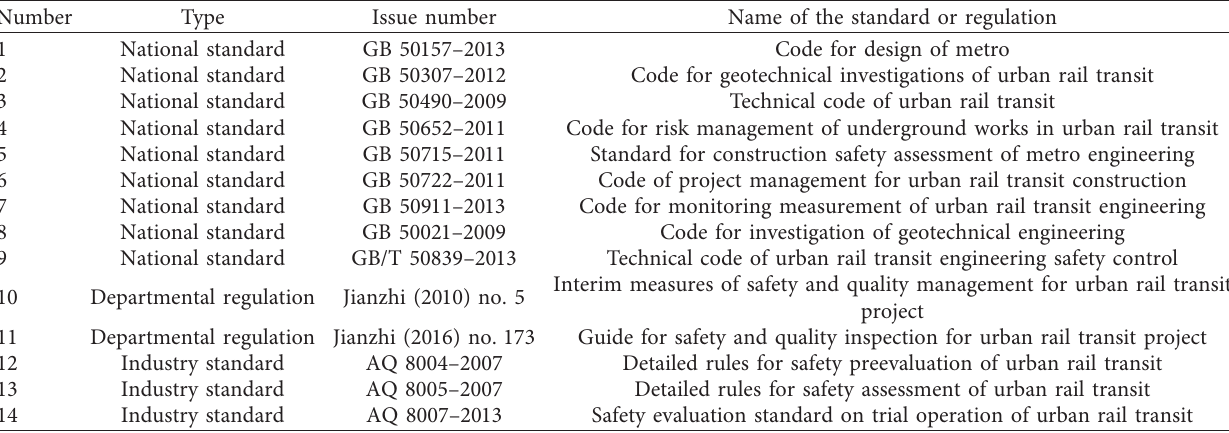
Table 1: Construction standards and regulations used in the case